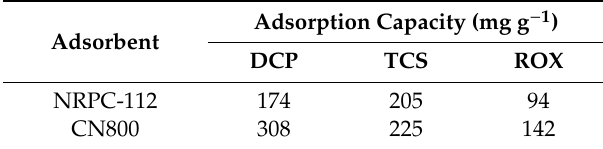
Figure 10. Equilibrium adsorption isotherms of NRPC-112 ( a ) dichlorophene (DCP), ( c ) triclosan (TCS), ( e ) roxarsone (ROX), Equilibrium adsorption isotherms of CN800 ( b ) DCP, ( d ) TCS, ( f ) ROX. Table 4. Adsorption capacity of NRPC-112 and CN800 in DCP, TCS and